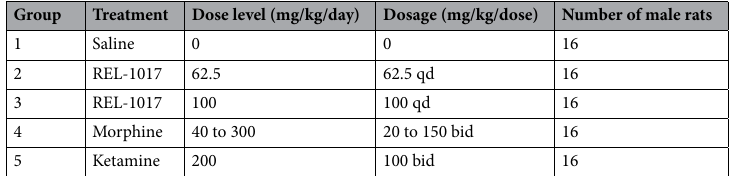
Table 2. Treatment assignment for assessing physical dependence and withdrawal symptoms/signs with REL- 1017 and